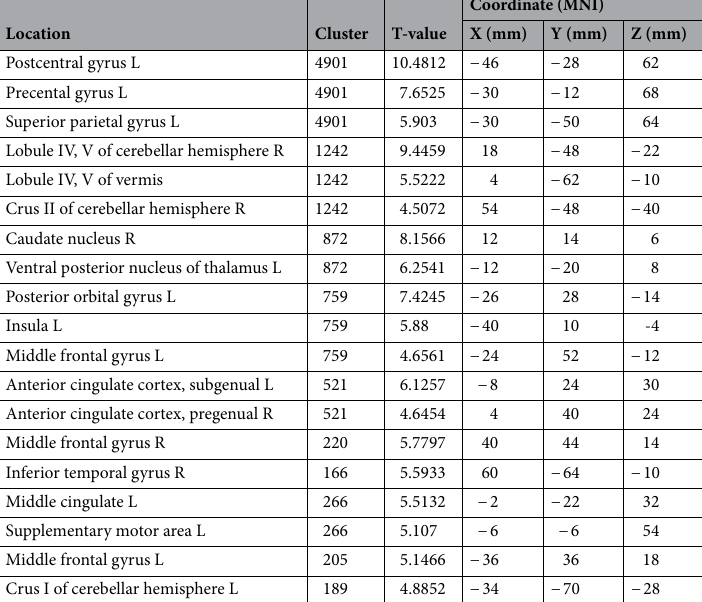
Table 1. Regions showing a significant main effect of